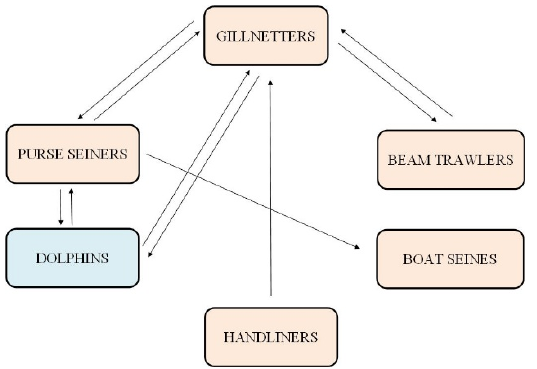
Figure 2. Conflicts between resource users in the Sea of Marmara [8,9]. The direction of the arrows displays the source of conflict.